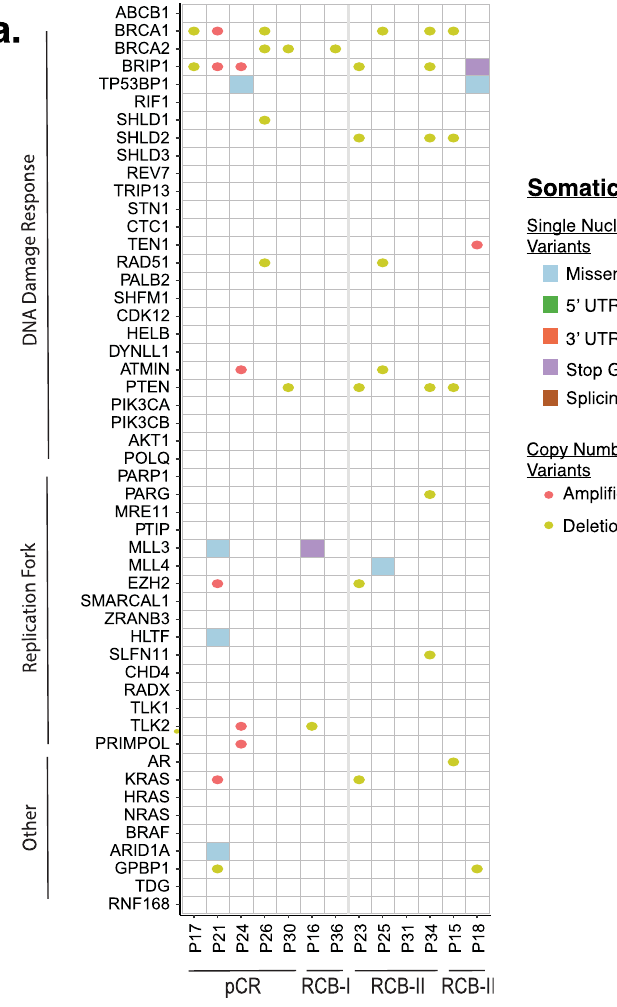
Fig. 2 Known resistance genes associated with resistance. a This oncoplot shows the mutations seen across a curated list of genes linked with resistance to PARPi. b The gene expression of members of the shieldin complex are shown on the Y -axis as log 2 TPM. Individual patients (dots) are grouped according to RCB response. Mean expressions are shown by red lines. The p -values are calculated from unpaired two-sided Student ’ s t tests. In the SHLD2 plot, patients predicted to have copy number loss of the gene are